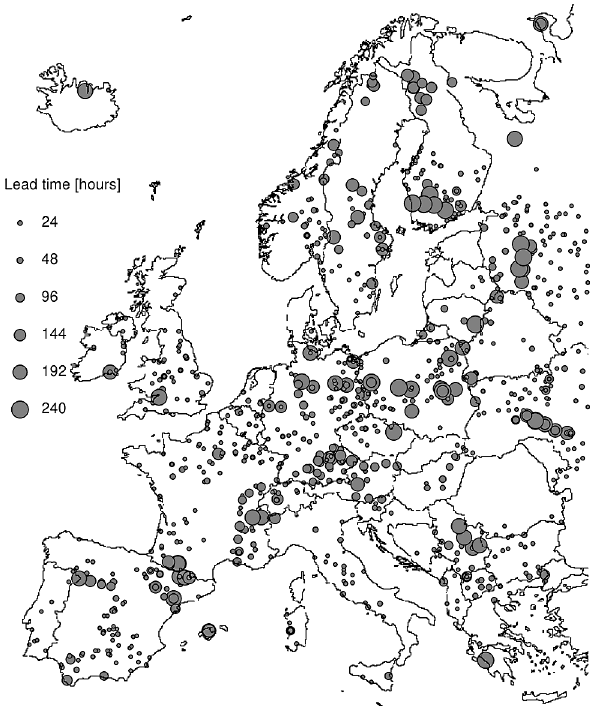
Figure 8. Location of flood alerts predicted in the 32-month period. Circle size is proportional to the lead time to the event peak.